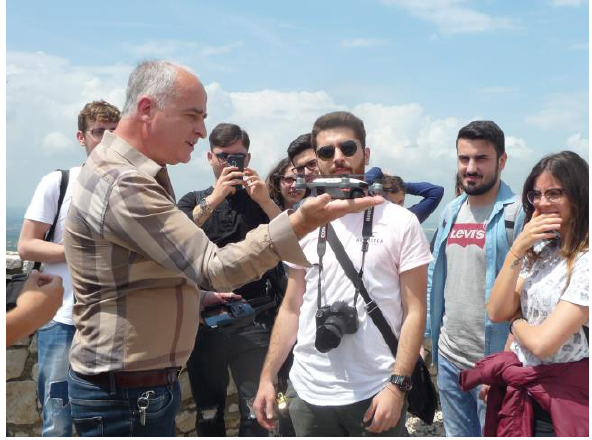
Figure 7: Survey with the drone DJI Phantom 4.